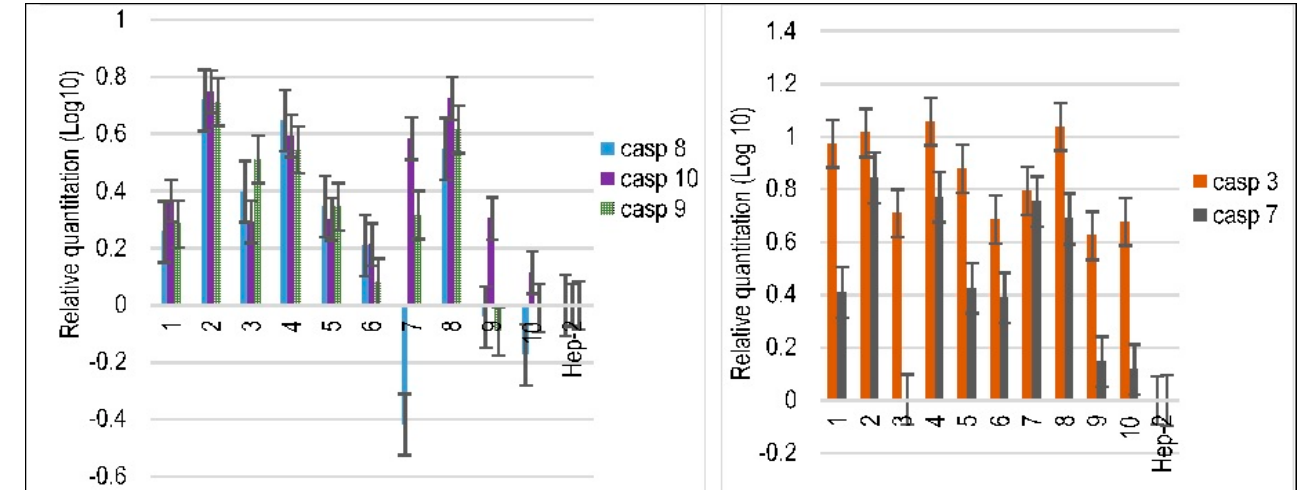
Figure 5. The intrinsic and extrinsic apoptotic caspase activation by 100 μ g/mL azulene ‐ containing chalcones.